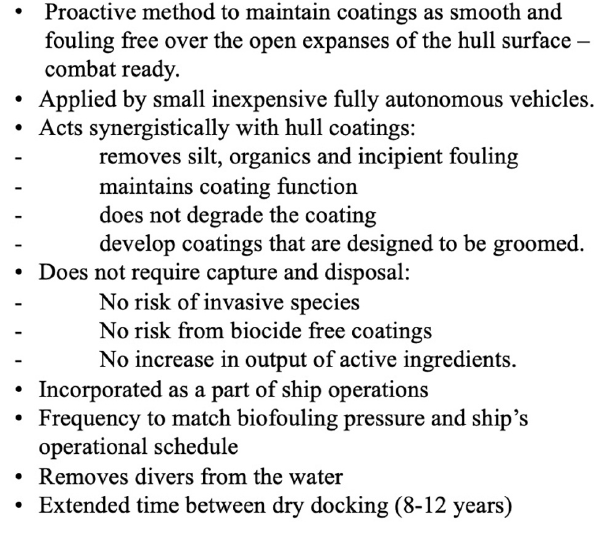
Frontiers in Marine Science |